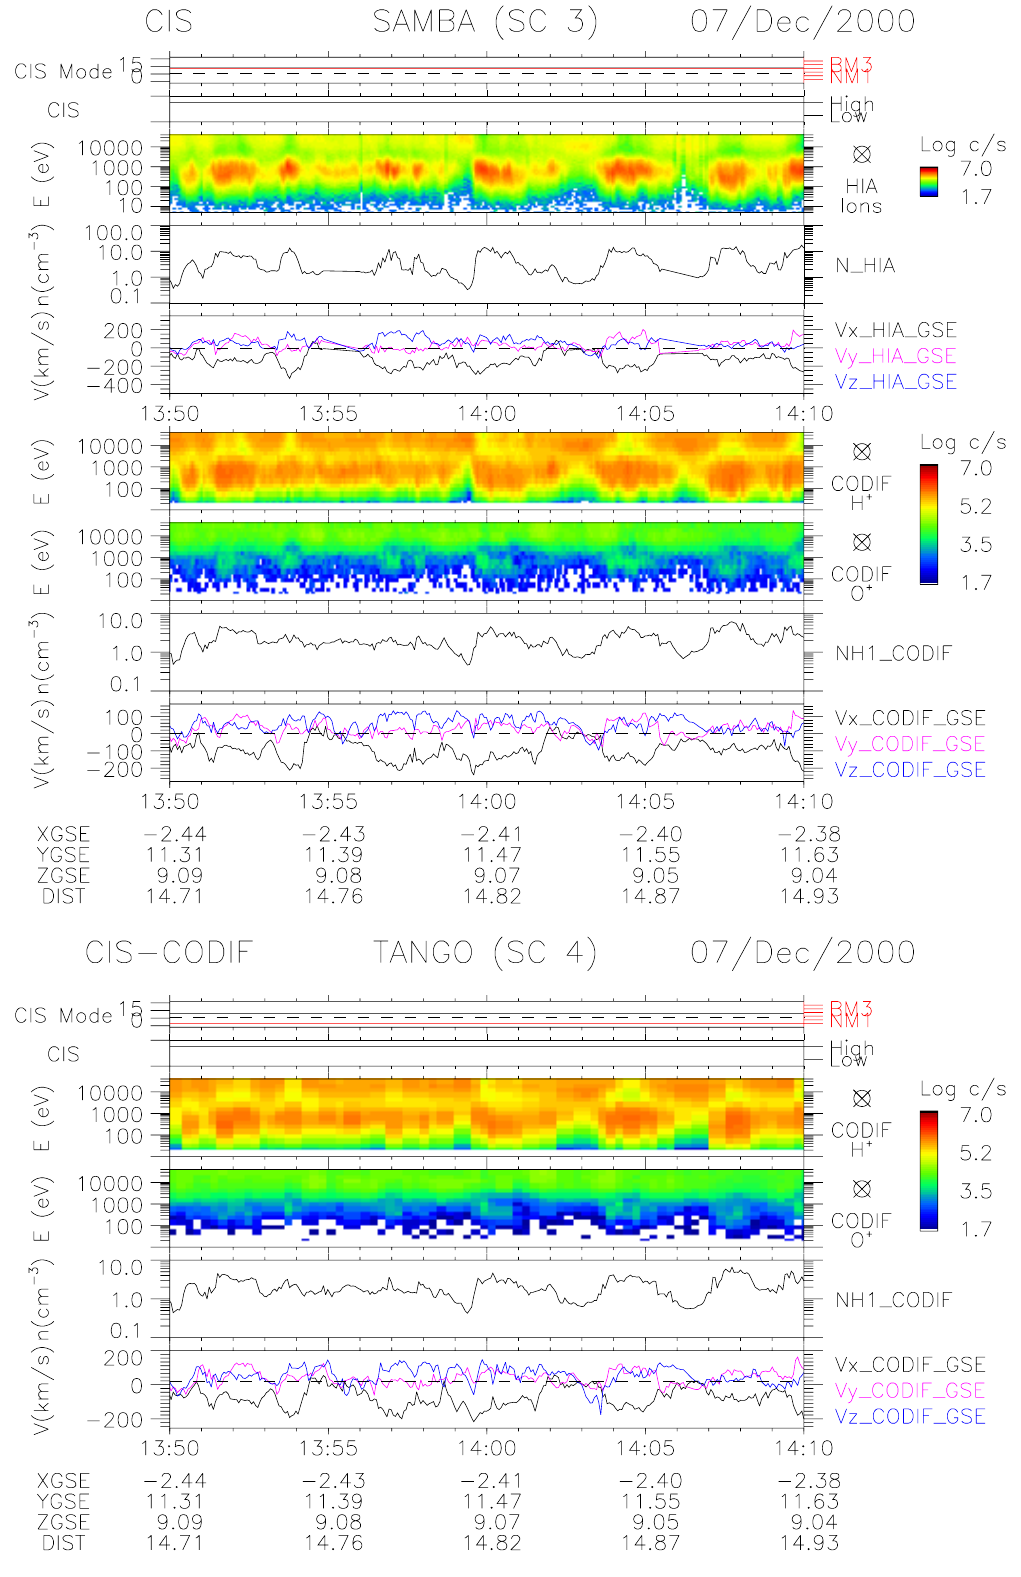
Fig. 28. HIA and CODIF measurements on spacecraft 3 and CODIF measurements on spacecraft 4, on 7 December 2000 between 13:50 and 14:10UT. See caption of Fig. 22 for the description of the